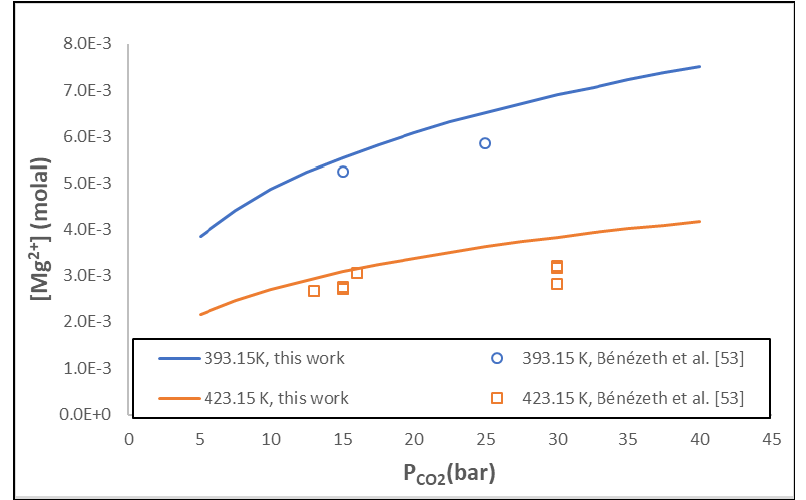
Figure 6. Calcite solubility in pure water or NaCl solutions calculated by this model at different temperature, pressure and NaCl molality. ( a ) Calcite solubility in pure water varying with pressure at different temperatures. ( b ) Calcite solubility in NaCl solutions varying with NaCl molality at 343.15 (K) and various pressures.